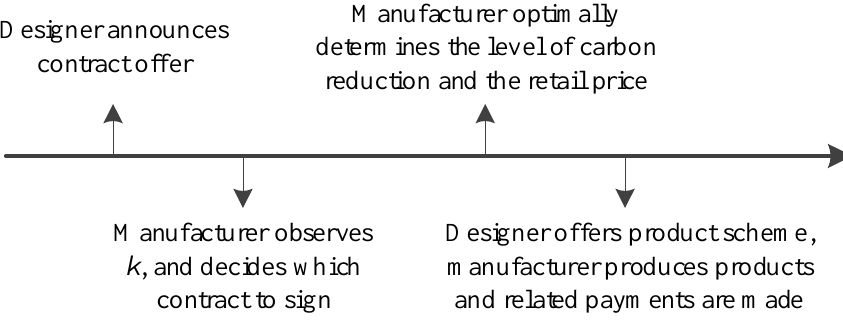
Figure 1. Decision sequence time under information asymmetry.